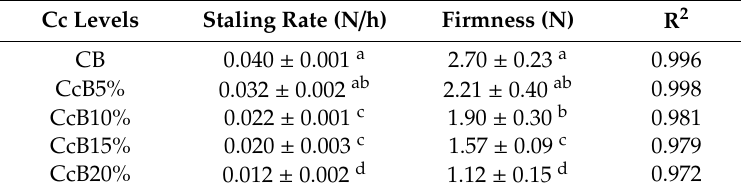
Table 4. Linear parameters derived by linear correlation (R 2 > 0.972): A—bread staling rate (N / h)